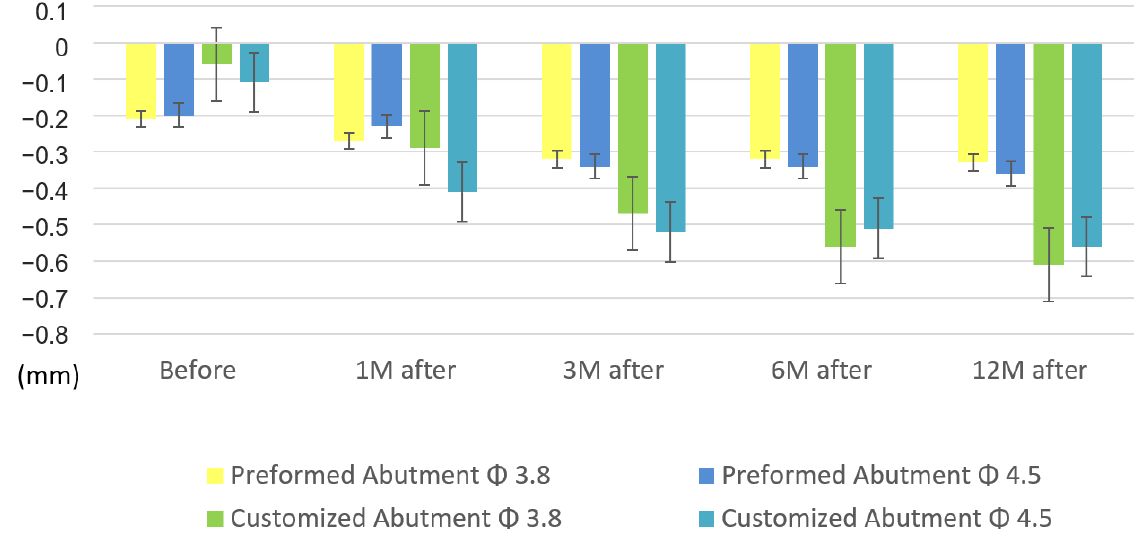
Figure 6. Comparison of groups by implant diameter of the PAs and CAs. CA, customized abutment; PA, preformed stock